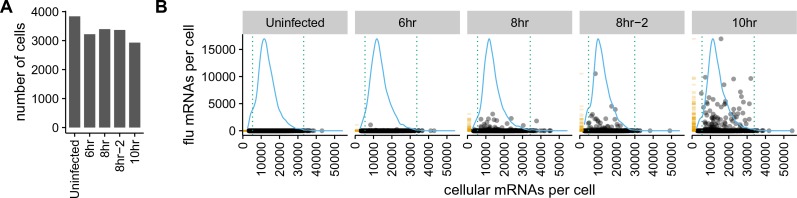
There is a very wide distribution in the amount of viral mRNA per cell.(A) Number of cells sequenced for each sample. (B) The number of cellular and viral mRNAs detected for each cell is plotted as a point. The blue lines show the overall distribution of the number of cellular mRNAs per cell. The orange rug plot at the left of each panel shows the distribution of the number of viral mRNAs per cell. Cells outside the dotted green lines were considered outliers with suspiciously low or high amounts of cellular mRNA (possibly derived from two cells per droplet), and were excluded from all subsequent analyses. Figure 3—figure supplement 1 shows the exact distributions of the fraction of viral mRNA per cell.